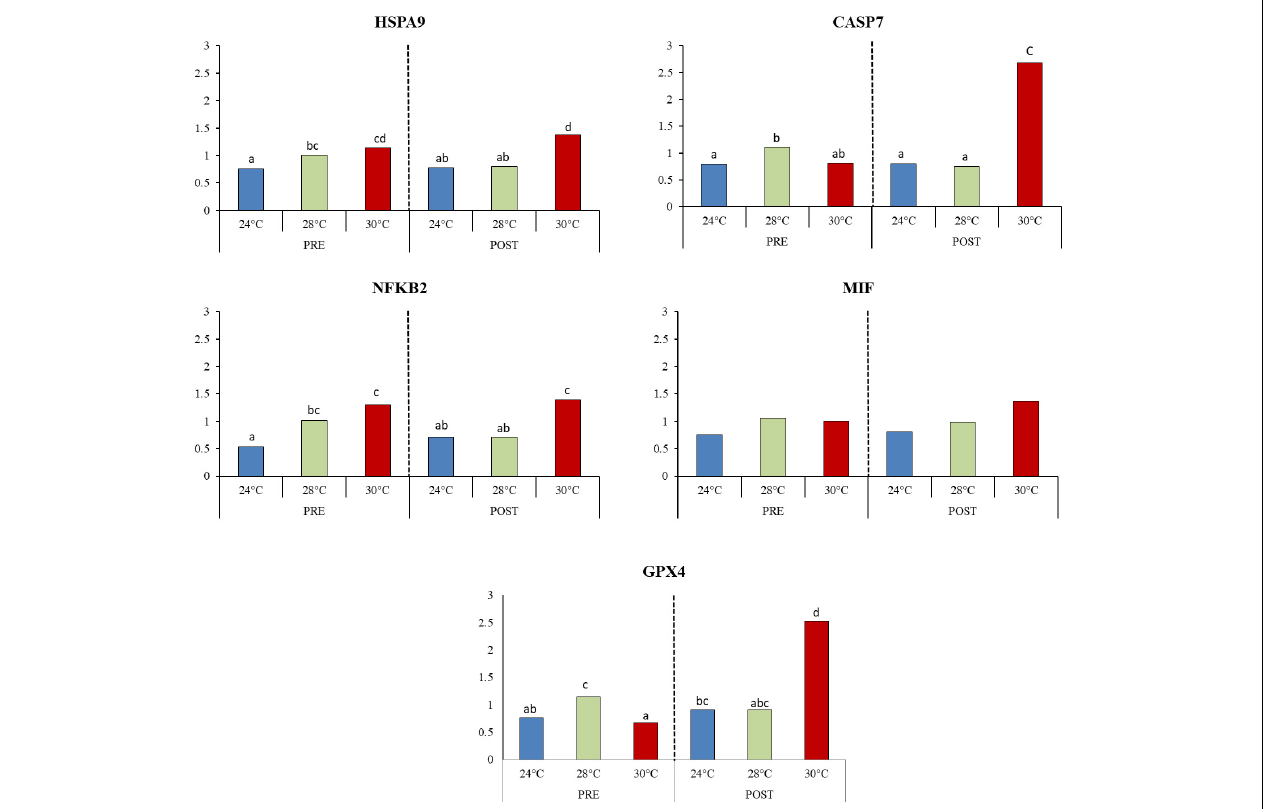
FIGURE 9 | Relative expression of transcripts associated with thermal stress response. Mean values (back-transformed from logarithms) are shown in bars and letters are used to denote differences between means ( P <